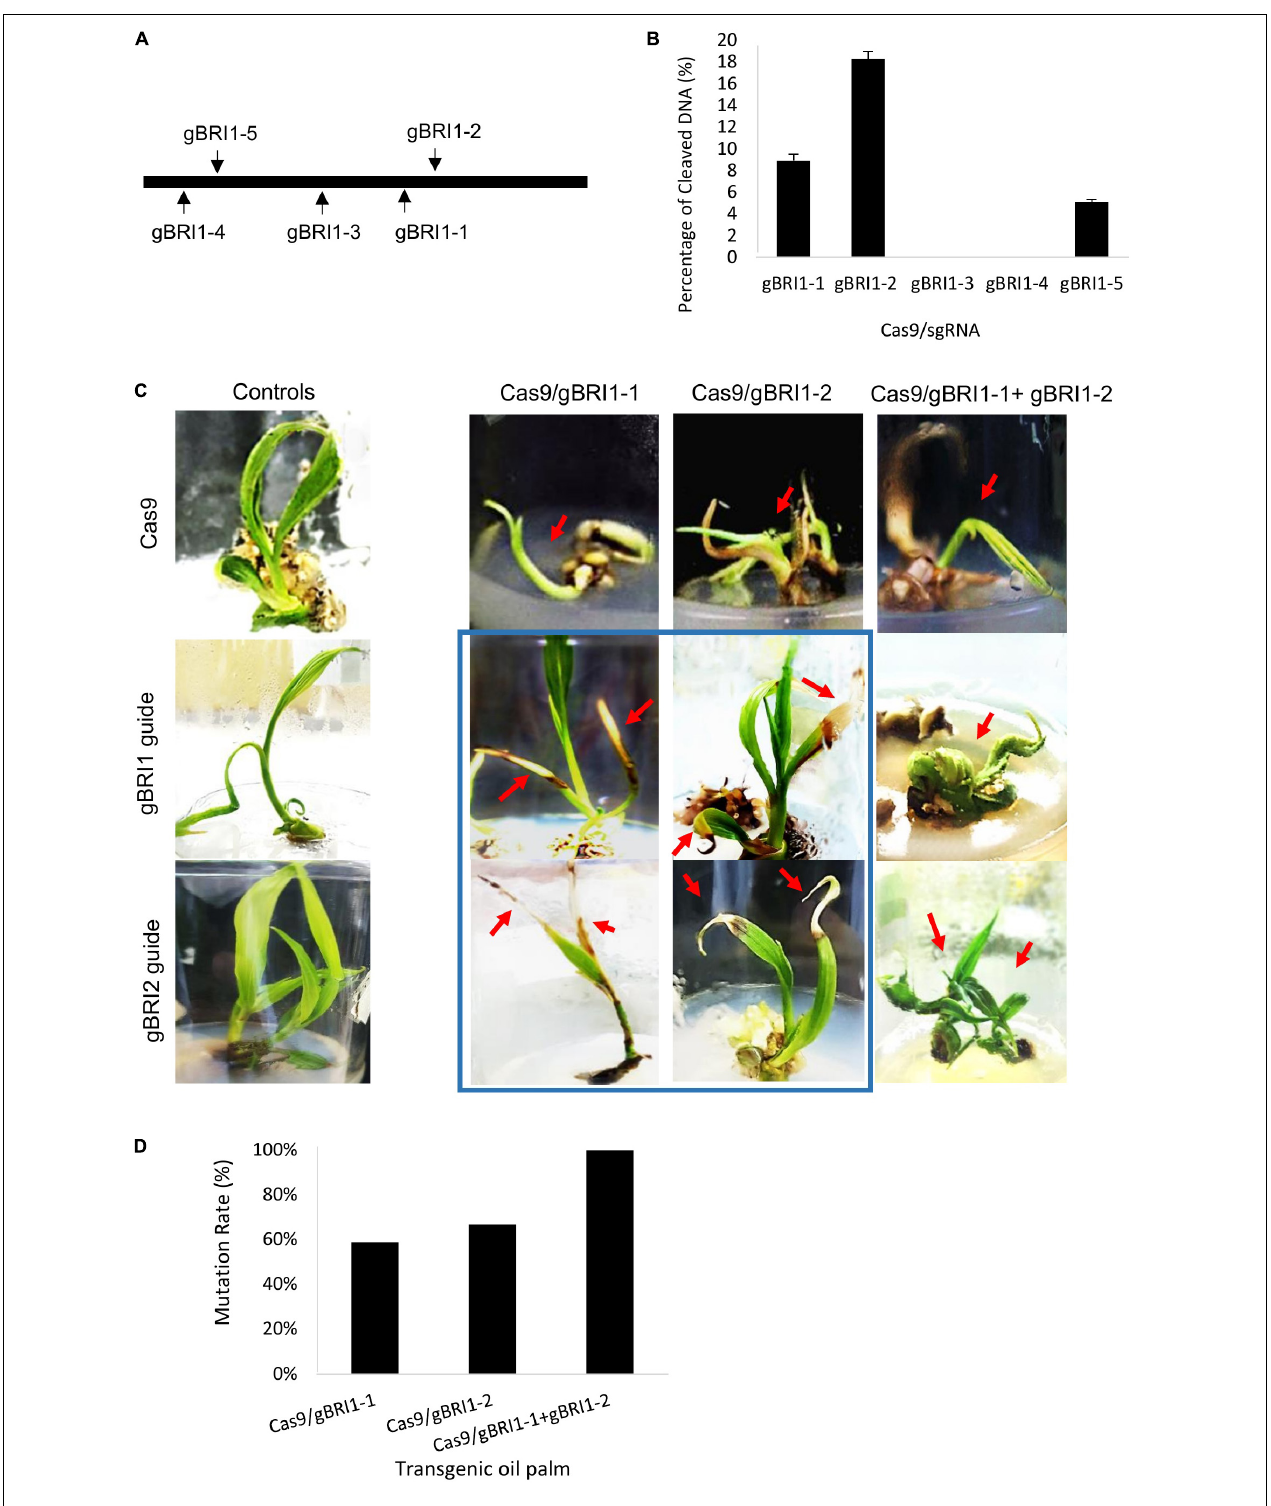
FIGURE 4 | Clustered regularly interspaced short palindromic repeat/Cas9-targeted mutagenesis of brassinosteroid-insensitive 1(EgBRI1) gene in in vitro oil palm plantlets. (A) Schema of gRNA targeting intronless EgBRI1 gene in oil palm. (B) Cleavage efficiency of Cas9/gRNA targeting EgBRI1 gene in oil palm protoplast. Data are average values ± SE from four independent experiments. (C) CRISPR/Cas9-induced EgBRI1 mutations at different gRNA target sites showing stunted growth and leaf apex necrosis phenotypes (boxed in blue) in transgenic oil palm shootlets and controls transformed with either Cas9 or gRNA alone. (D) Mutation frequencies of CRISPR/Cas9 mutagenesis based on the occurrence of stunted or necrotic leaf apex phenotypes in transgenic oil palm.